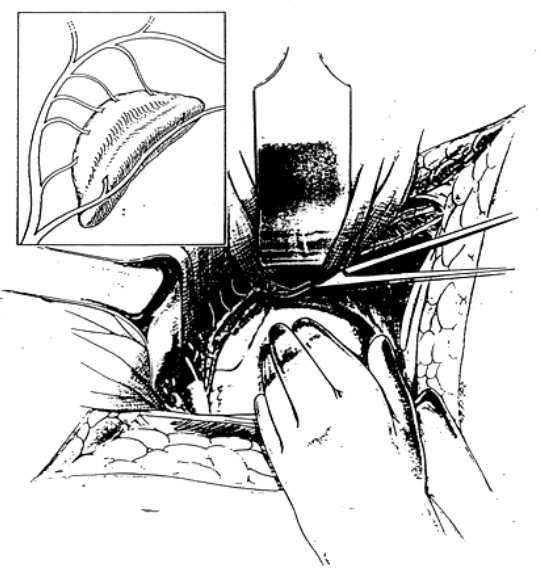
FIGURE 9 . Cephalad exposure of the left adrenal with careful division of arterial